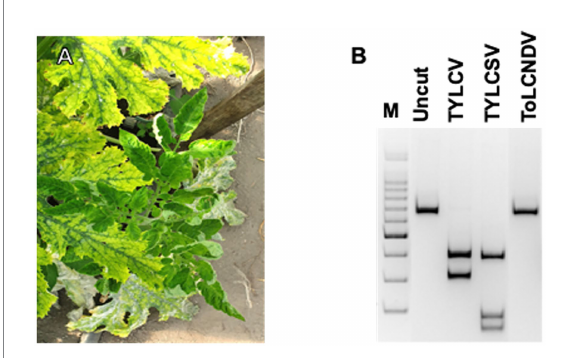
FIGURE 1 Virus detection on tomato plants: (A) symptomatic tomato plant, grown spontaneously among plants of a zucchini crop, also showing geminivirus symptoms; (B) PCR-RFLP based on Ava II digestions of the amplicons obtained by PCR with Gem1f/Gem2r primers on DNA extracted from tomato plants individually infected by the three